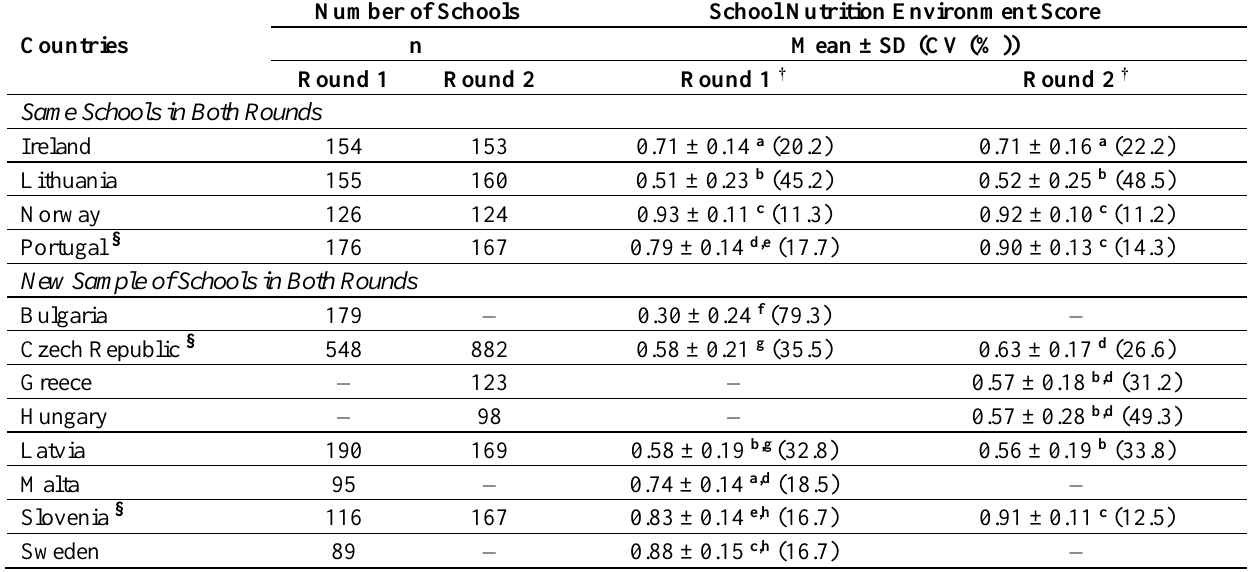
Table 3. School nutrition environment score characteristics of the schools that provided information on all five * selected characteristics in COSI rounds 1 (2007/2008) and 2 (2009/2010), by sampling approach and